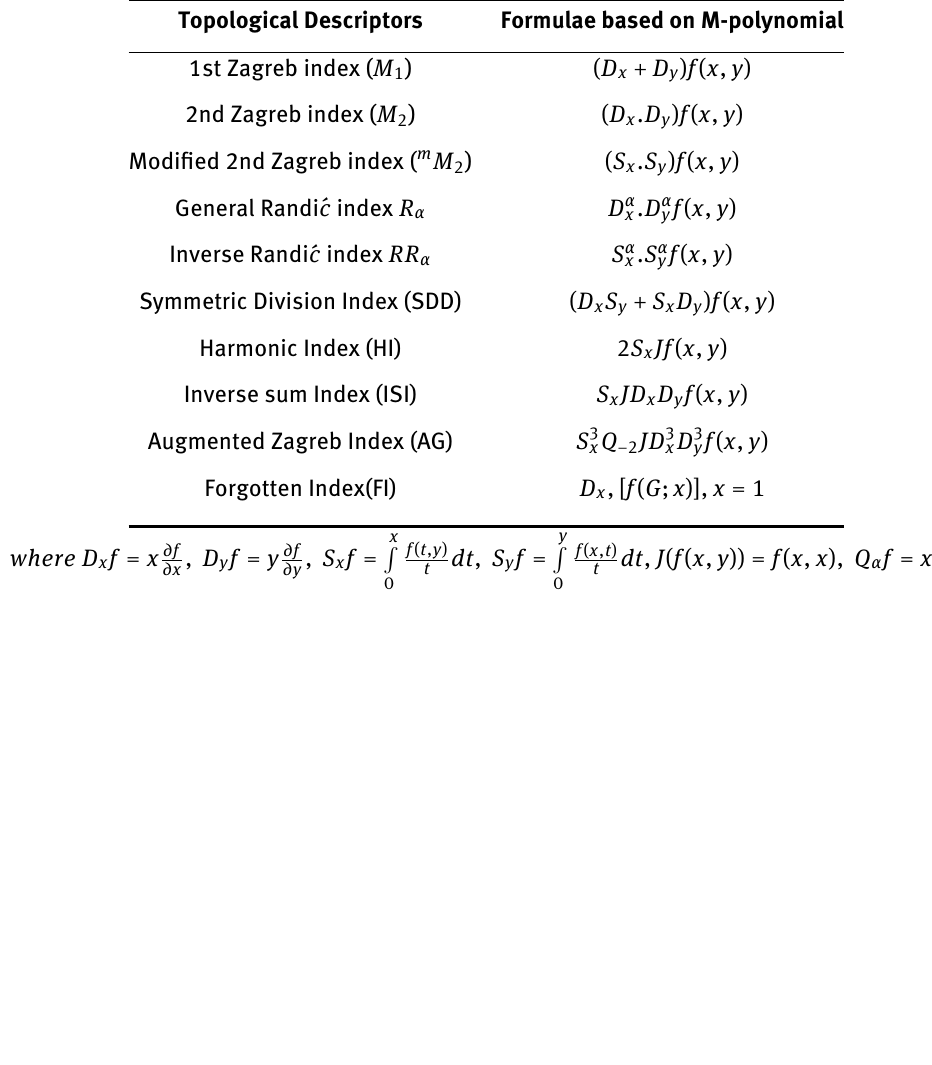
Table 1: Formulae of some prominent topological descriptors depending on M-polynomial.